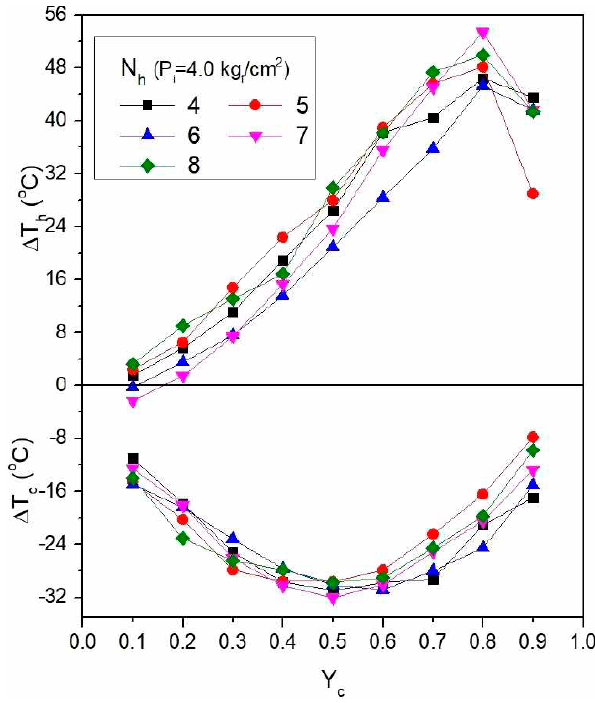
Figure 18. Temperature differences ∆ T h and ∆ T c according to inlet pressure (P i ) 4.0 kgf/cm 2 .